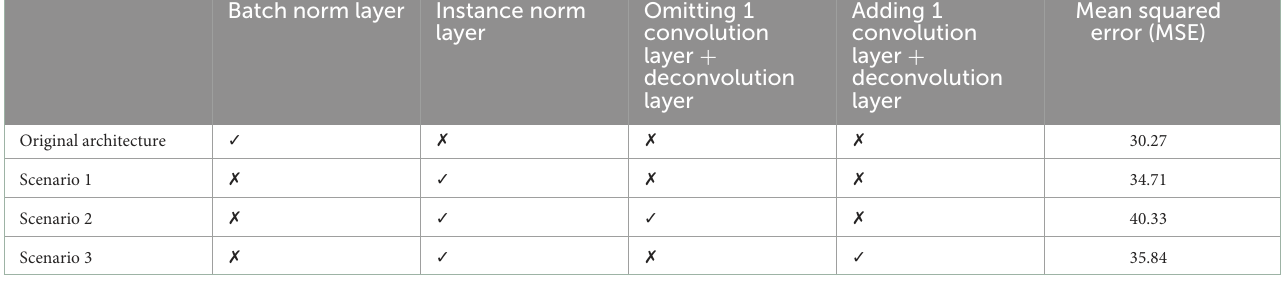
TABLE 4 Ablation analysis of SM3 model.